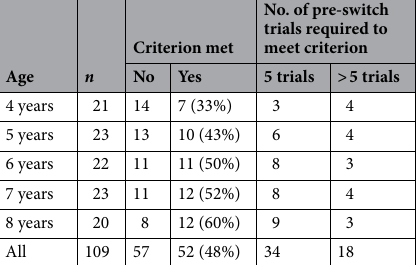
Table 1. Number of children who met criterion by age in years ( N = 109) and, for those who met criterion ( N = 52), the number of pre-switch trials required to do so.